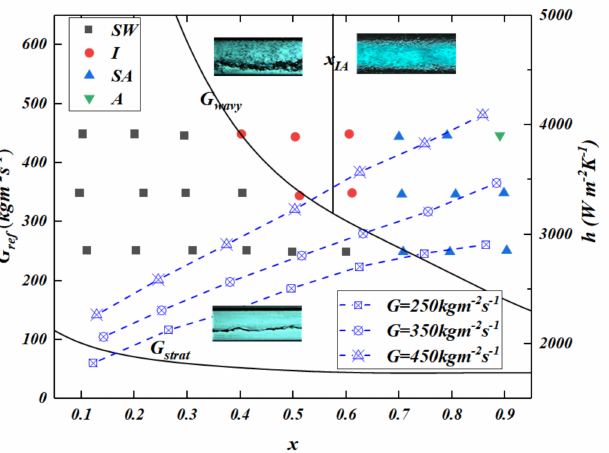
Figure 10. Flow patterns and HTC ( h ) in a smooth tube as a function of quality ( x ) for different mass flow rates ( G